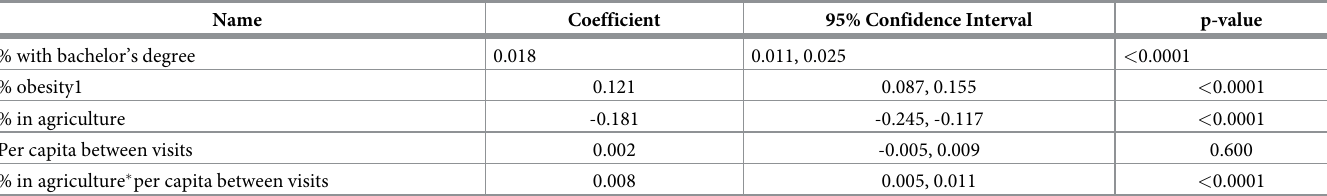
Table 3. Final global negative binomial model showing significant predictors of COVID-19 risk in the Greater St. Louis Area, Missouri (USA).